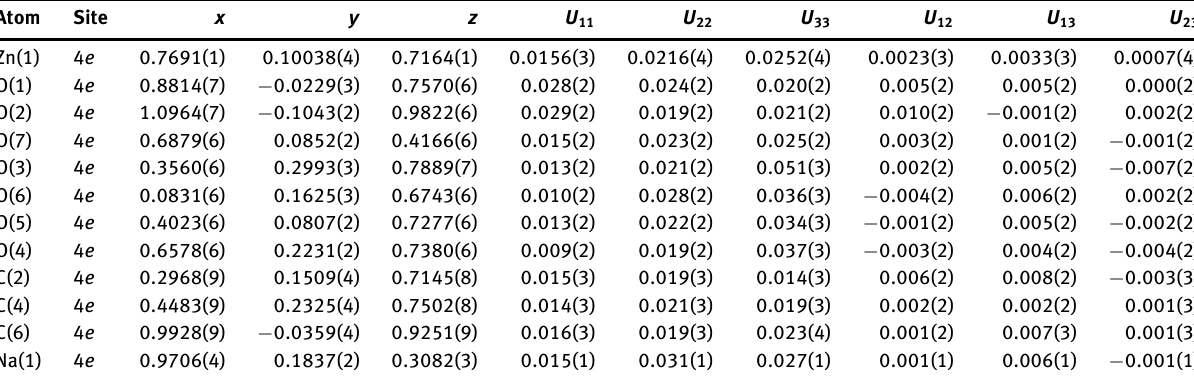
Table 3: Atomic displacement parameters (Å 2